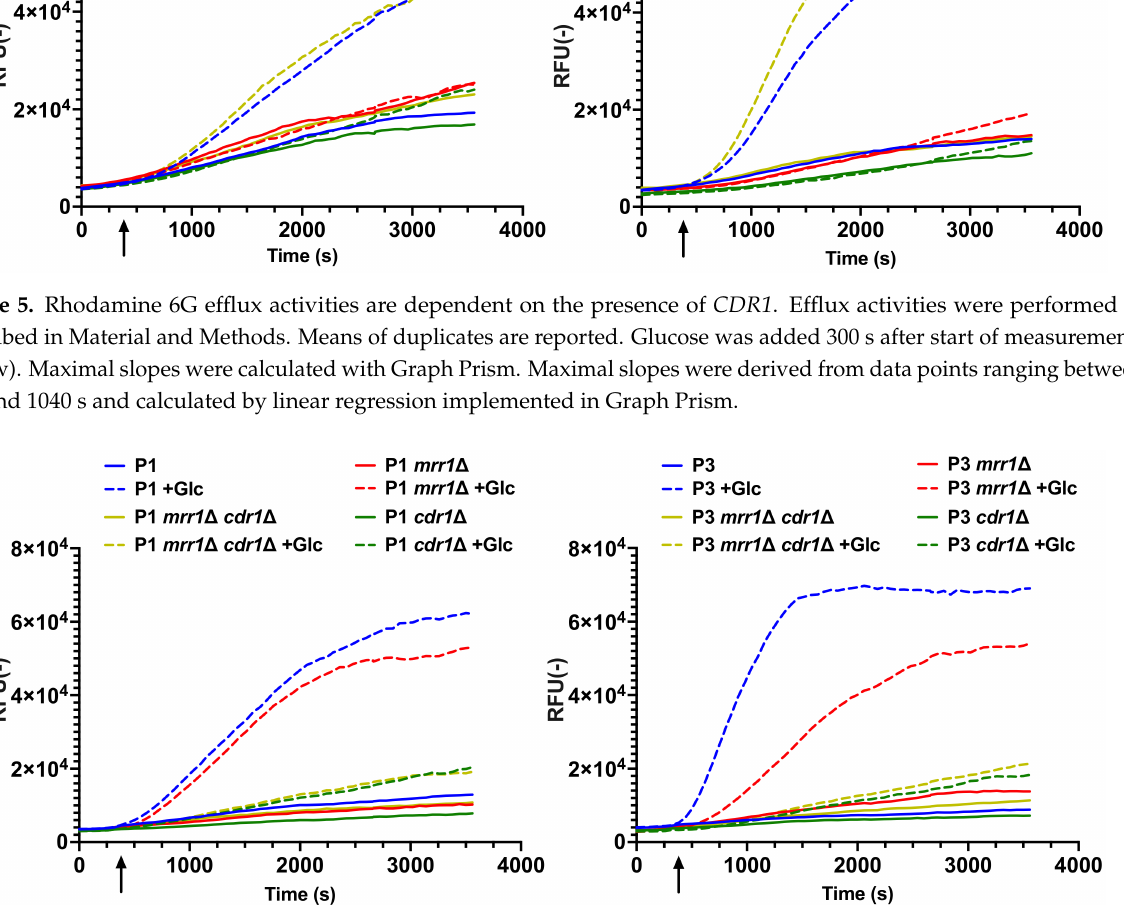
Figure 6. Rhodamine 6G efflux activities are dependent on the presence of CDR1 and MRR1 . Efflux activities were performed as described in Material and Methods. Means of duplicates are reported. Glucose was added 300 s after start of measurements